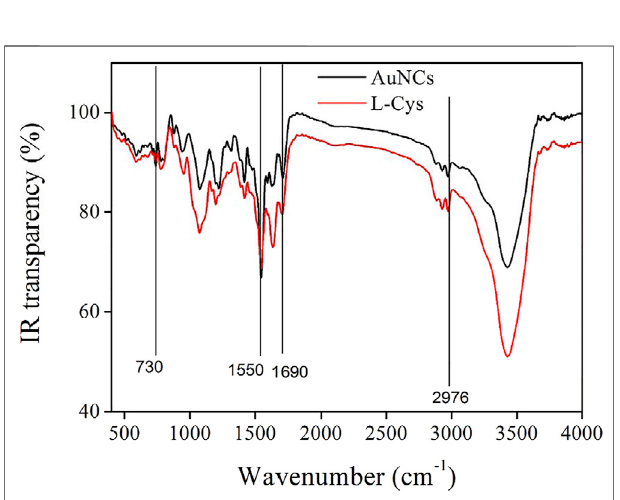
FIGURE 4 | DLS (left) and Zeta potential (right) of the AuNCs dispersed in pure water (v:v (cid:1) 1:10).